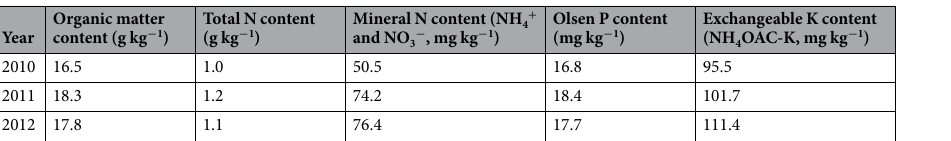
Table 6. Characteristics of soil fertility from 2010 to